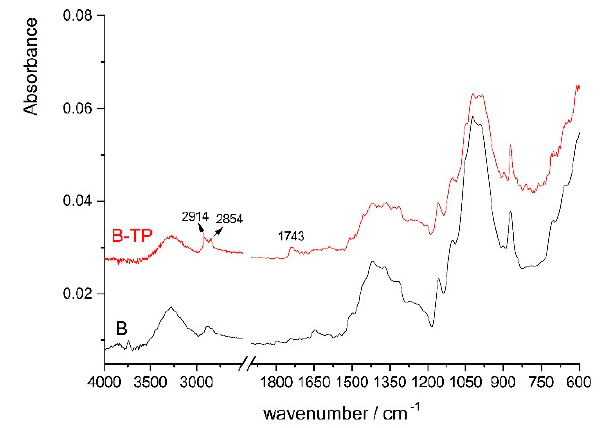
Figure 9. FTIR spectra of bulky paper (B) and thermochromic print on bulky paper (B-TP).